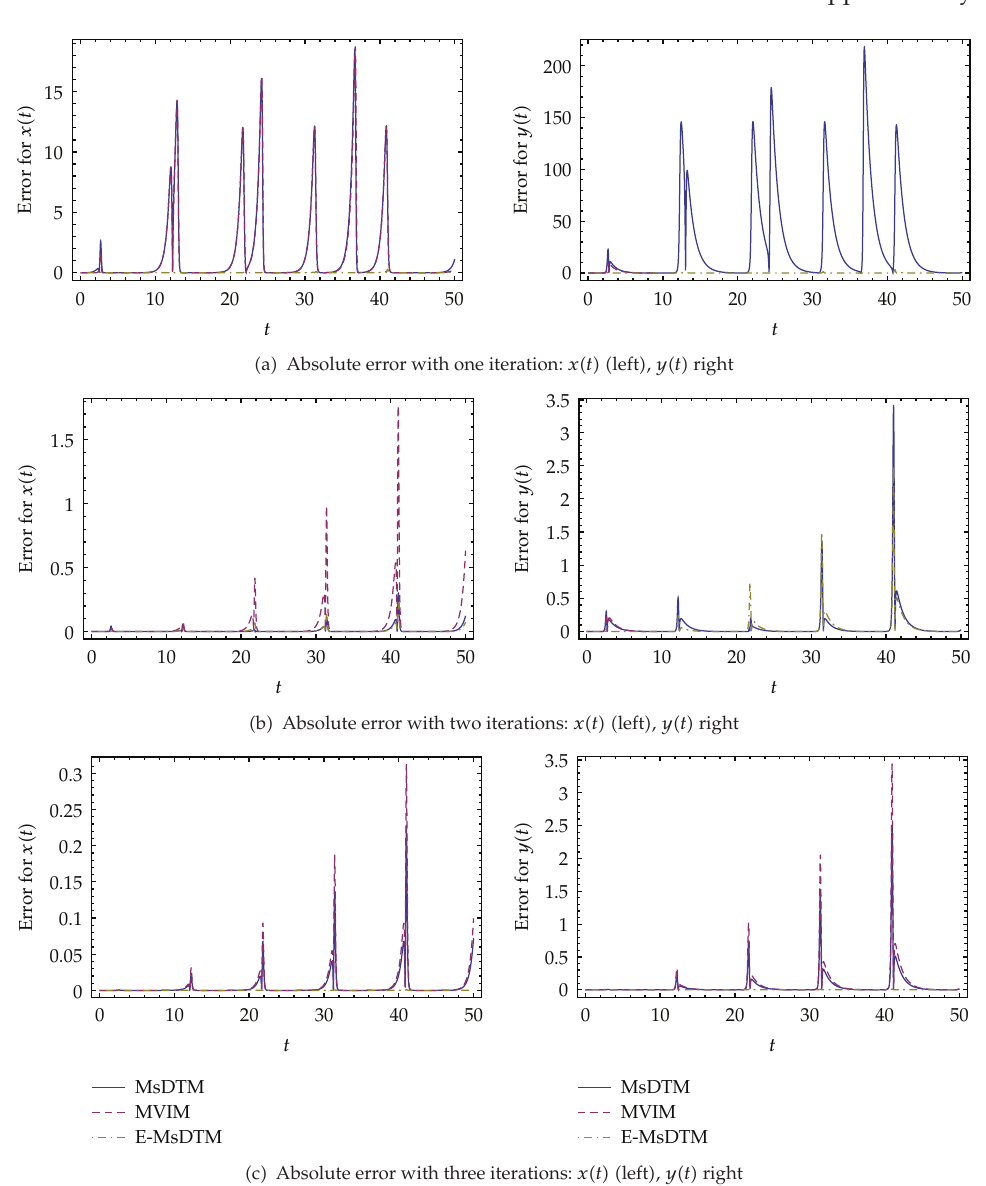
Figure 6: Comparison of absolute errors in case